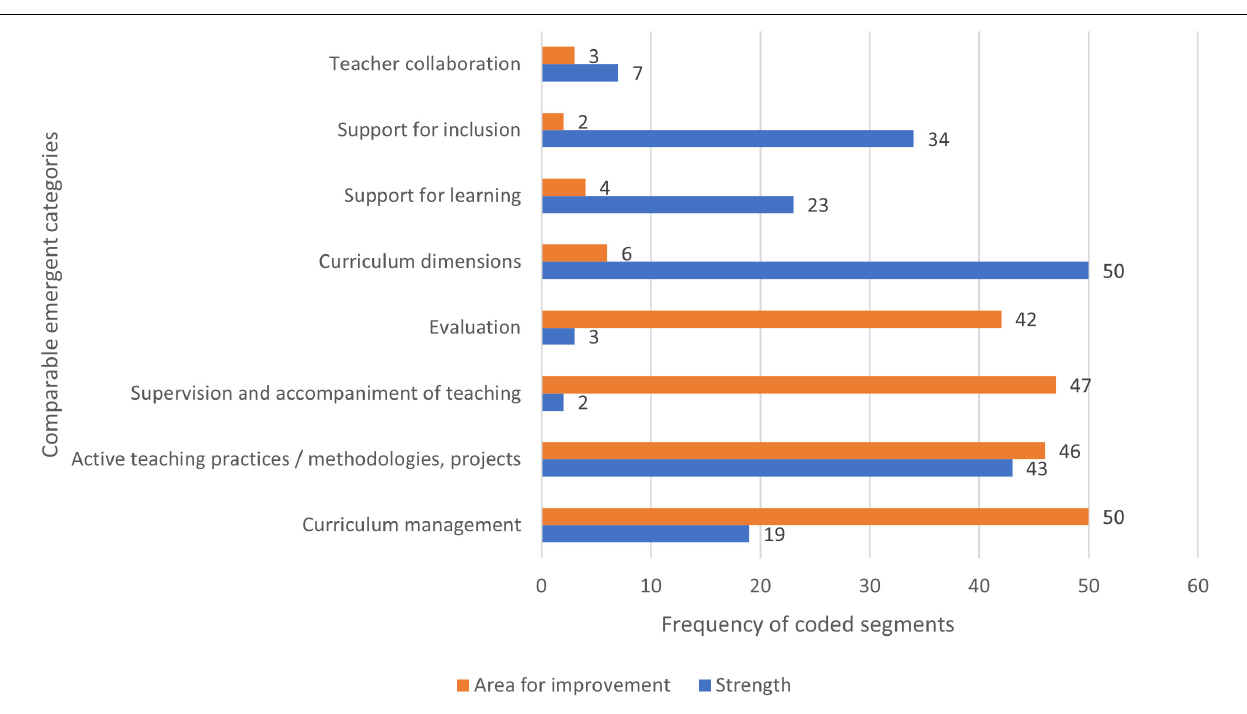
FIGURE 9 | Provision of educational service: a comparison between strengths and areas for